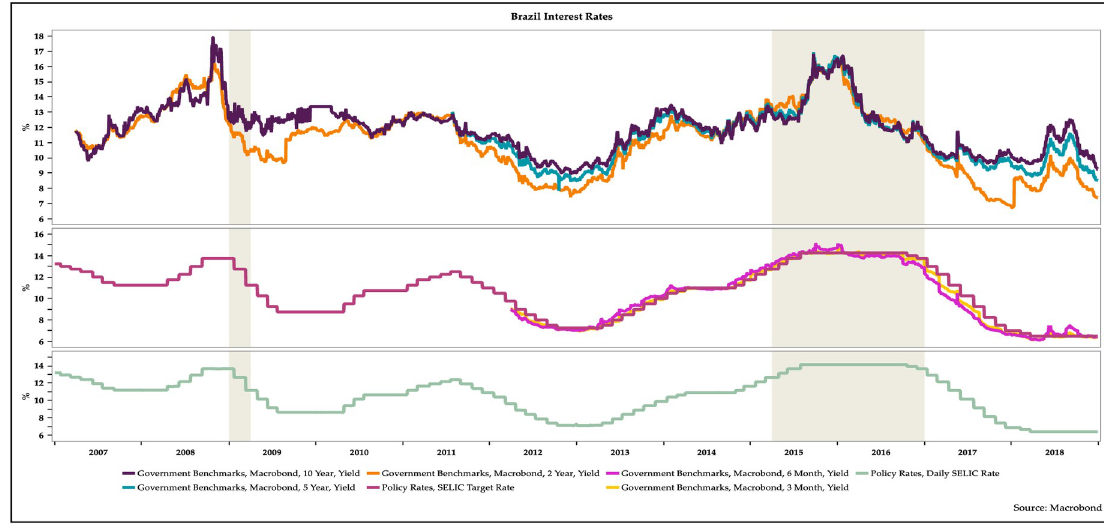
Fig 1. The evolution of key interest rates in Brazil, 2007–2018.